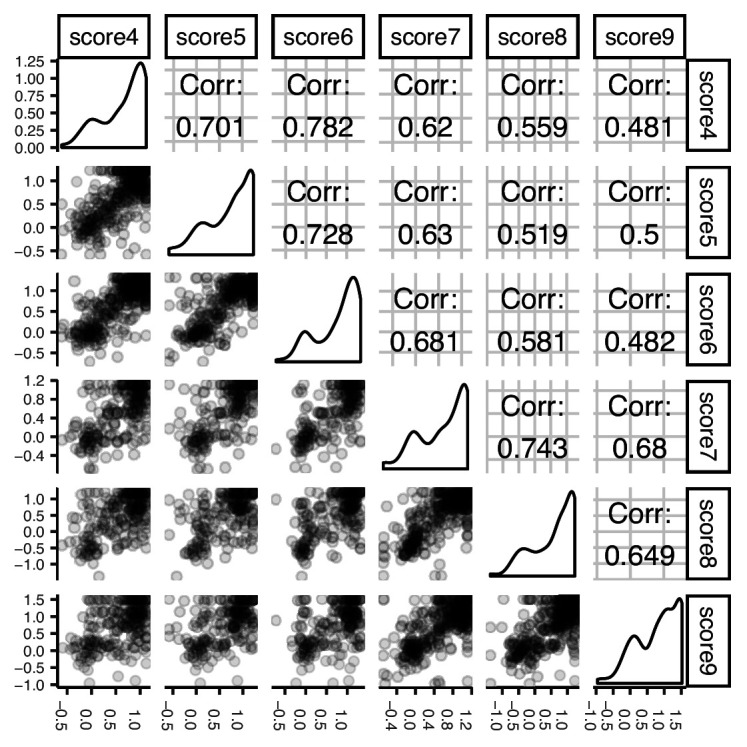
Correlations of activity assay replicates.Pairwise score correlations between replicate sorting experiments of VKOR activity. Six replicates of the activity assay were performed. Pearson’s correlation coefficients are shown. Score numbers in this panel correspond to replicate numbers shown in Supplementary file 2.